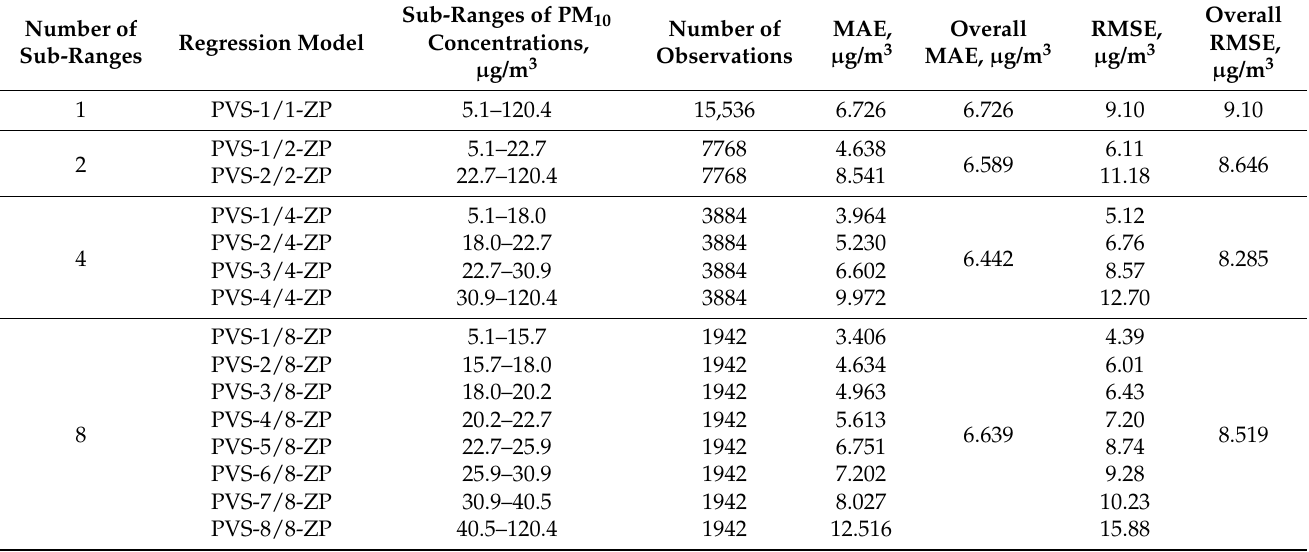
Table 20. Values of approximation errors of PM 10 concentrations in PVS models, Złoty Potok 2011–